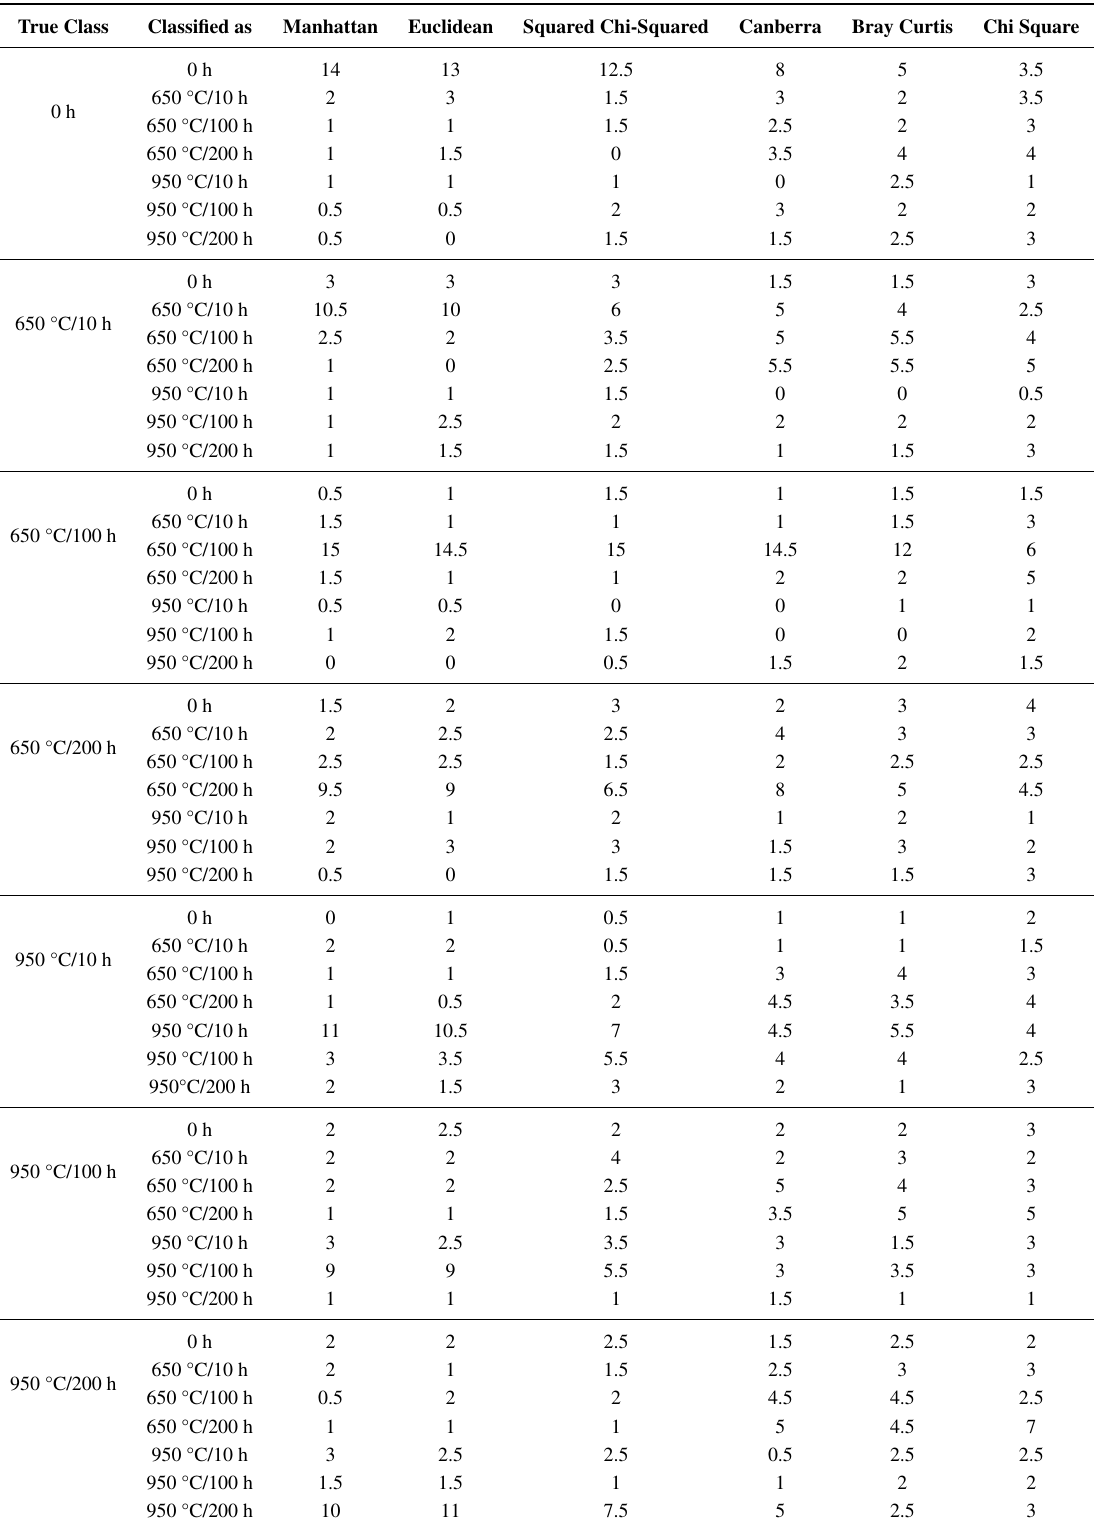
Table 18. Confusion matrix of the classification means for the 5-MHz frequency pulse echo signals at 650 and 950